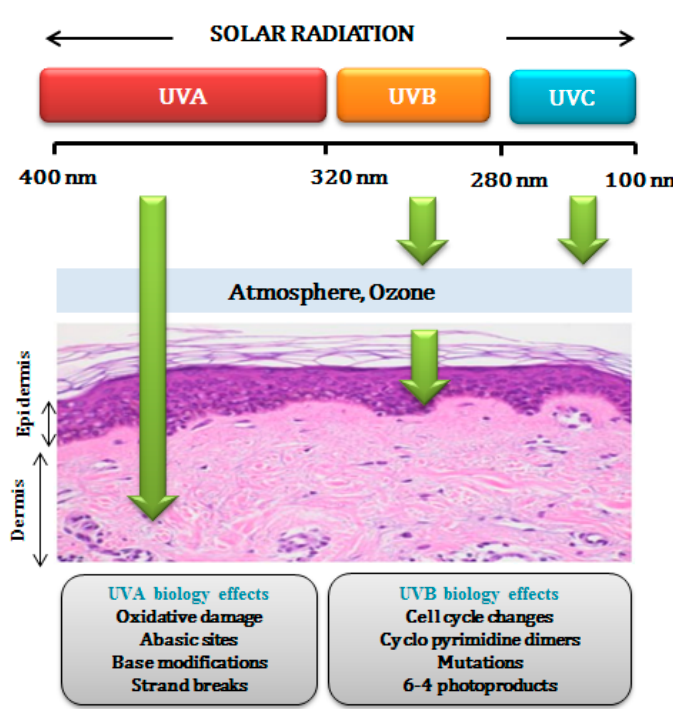
Figure 1. Electromagnetic spectra solar ultraviolet (UV) rays and their biologic effects on the skin [2].